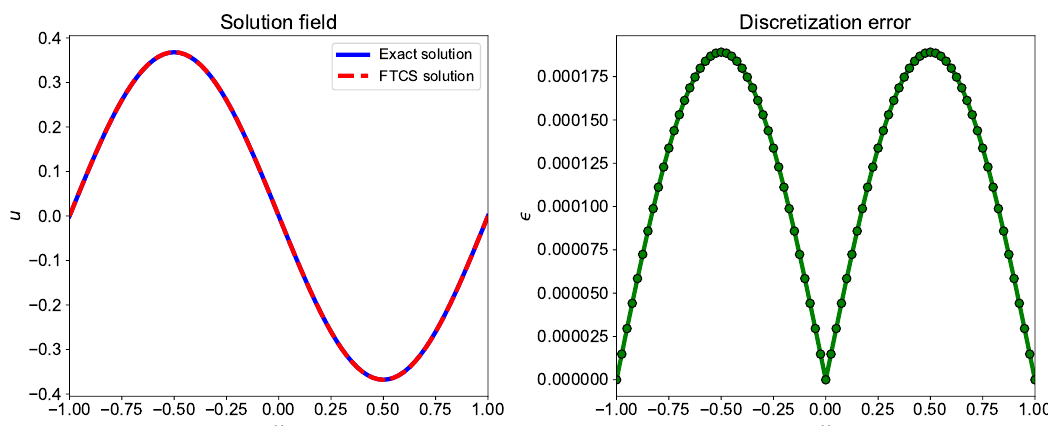
Figure 3. Comparison of exact solution and numerical solution computed using third-order Runge-Kutta numerical scheme. The numerical solution is computed using ∆ t = 0.0025 and ∆ x =